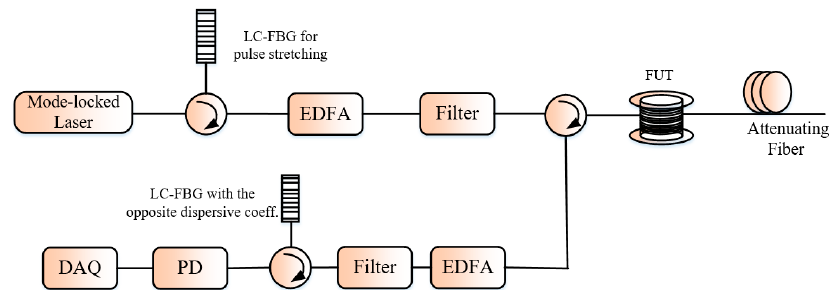
Figure 8. Setup of the chirped pulse Φ‐ OTDR system. LC ‐ FBG: linearly chirped fiber Bragg grating.